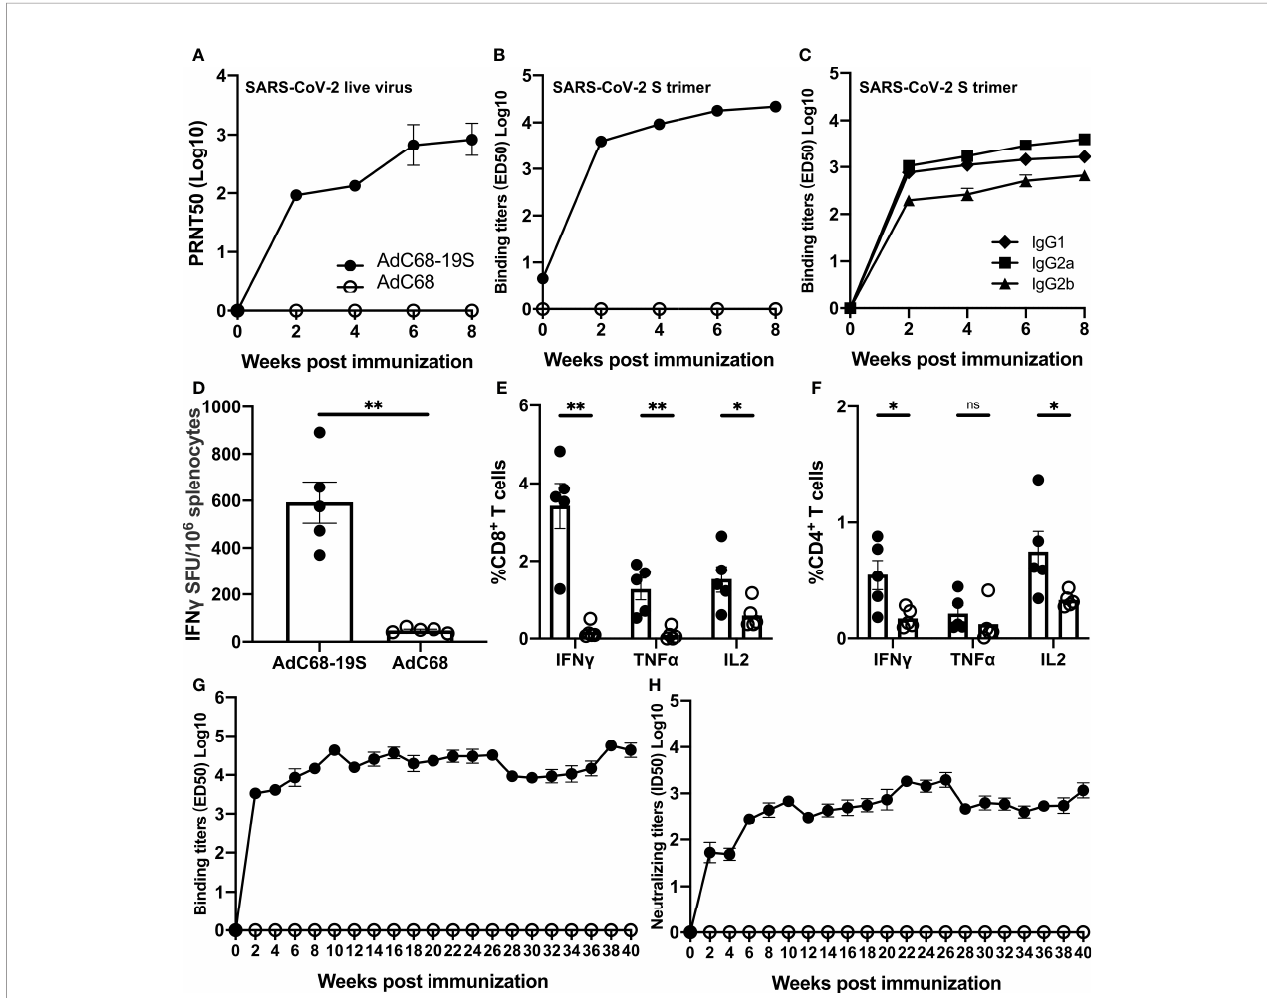
FIGURE 2 | AdC68-19S induces strong and durable immune responses in BALB/c mice. Animals immunized with 10 10 vp of AdC68-19S were characterized in greater detail. (A) Neutralizing activity of the immunized serum against live SARS-CoV-2 over an 8-week period after immunization. (B) Binding activity of the immune serum total IgG to SARS-CoV-2 S trimer. (C) Binding activity of immune serum IgG subtypes IgG1, IgG2a, and IgG2b to SARS-CoV-2 S trimer. (D) ELISPOT analysis of IFN- g -positive splenocytes and FACS analysis of intracellular IFN- g , TNF- a , and IL-2 production in (E) CD8 + and (F) CD4 + splenic T cells one week after immunization. The durability of the antibody response was analyzed using (G) ELISA of total IgG with the SARS-CoV-2 S trimer and (H) pseudovirus neutralization up to 40 weeks after single-dose immunization. Data corresponding to animals in the AdC68-19S group are shown in solid circle, and those in the AdC68 group in hollow circle. All data are presented as the means ± SEM. Analysis of unpaired Mann – Whitney test was used to determine the statistical signi fi cance of differences among different groups (*P < 0.05; **P < 0.01; ns, no signi fi